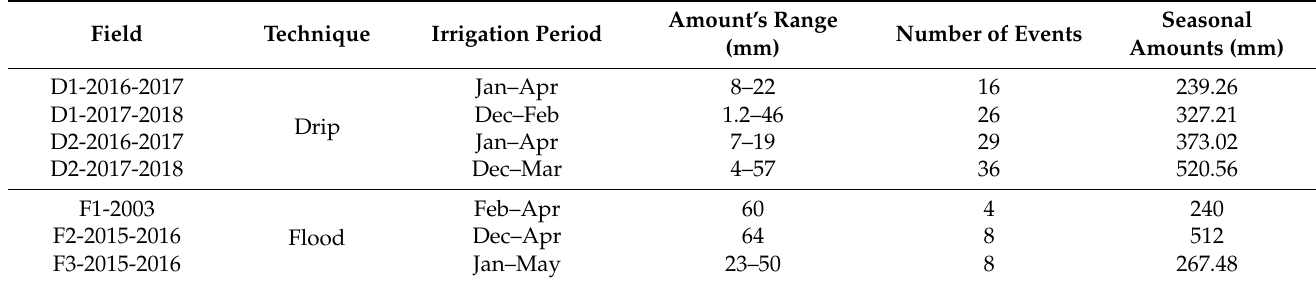
Table A1. Irrigation general information of the irrigated fields.